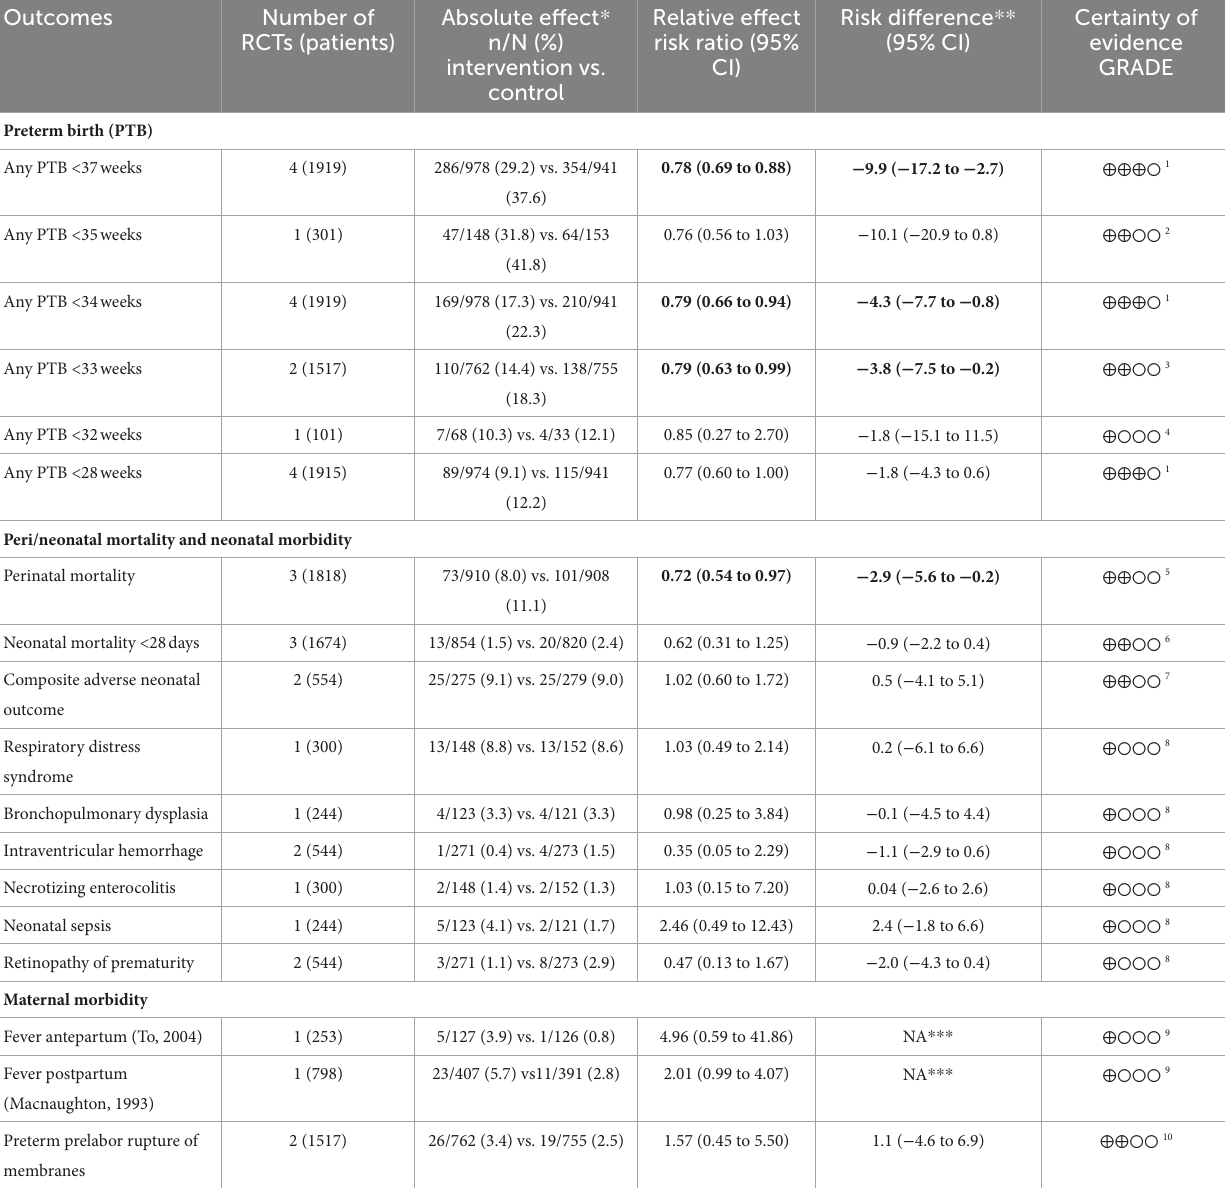
TABLE 3 Summary of findings for main outcomes (based on trials with low risk of bias): Cerclage vs no cerclage in women with a singleton pregnancy and any risk factor(s) for preterm